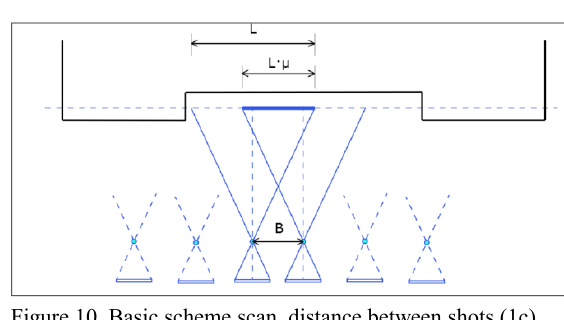
Figure 9. Scan front scheme (1b)